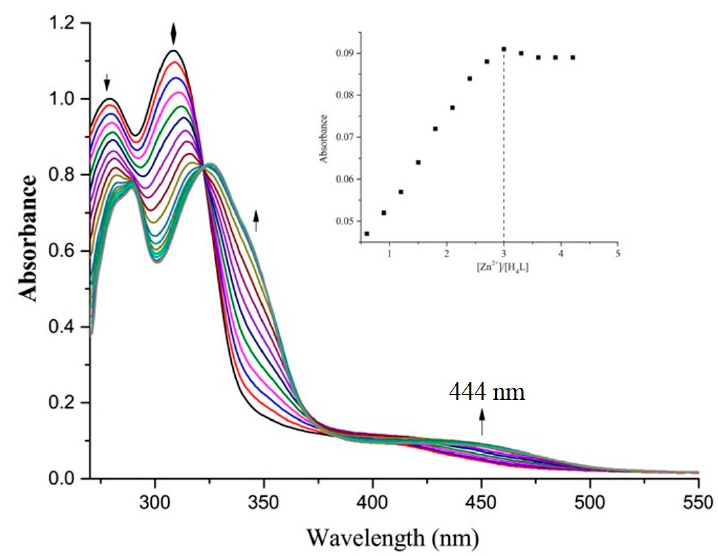
Figure 2. Absorption spectra of H 4 L in DMF with the increase of Zn II . Inset: the absorbance at 444 nm varied as a function of [Zn 2+ ]/[H 4 L]. [H 4 L] = 5 × 10 − 5 mol/L.